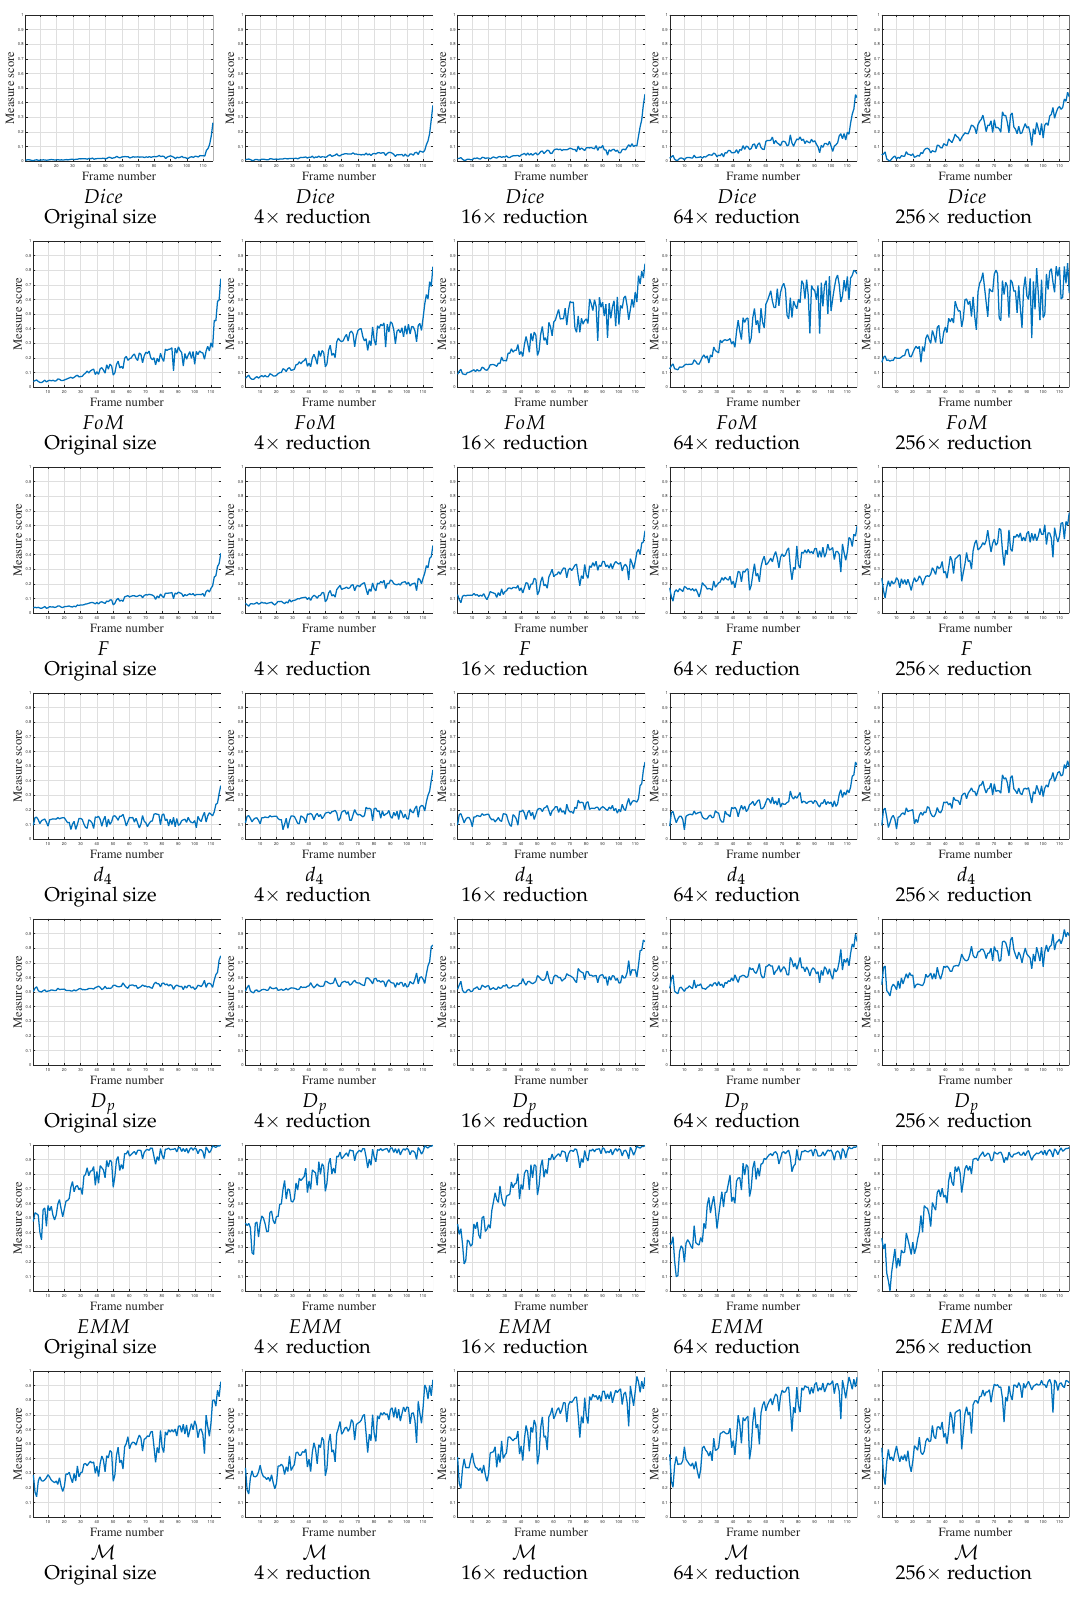
Figure 12. Localization metrics behaviors on real experiment concerning video 4 (V4) of 116 frames. The parameter concerning FoM , F , d 4 and D p is κ = 1/9. Concerning M , the parameters are µ FP = 1/ ∆ 2 and µ FN = 1/ ∆ , so µ FP < µ FN